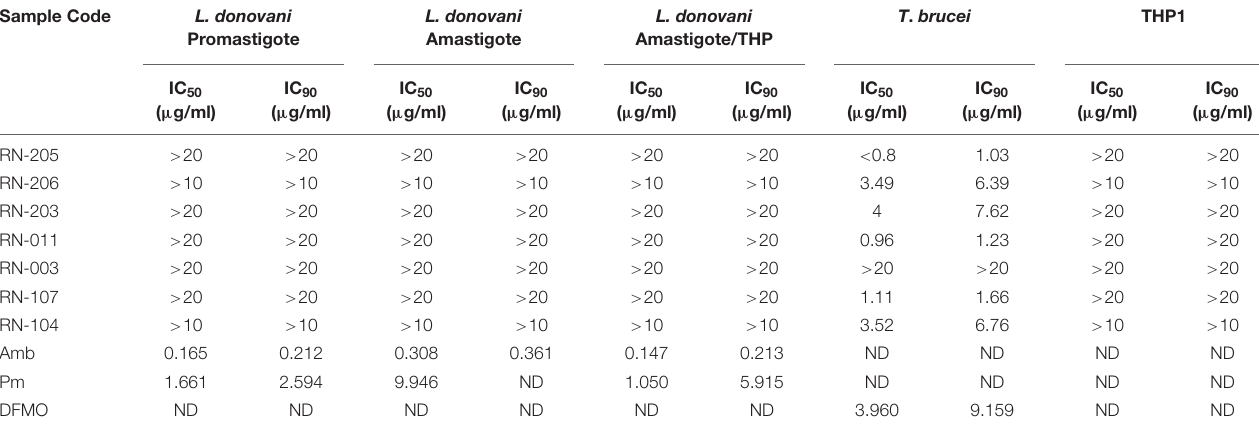
TABLE 4 | Antileishmanial and antitrypanosomal assays of the EtOAc extracts of the isolated microorganisms showing high antitrypanosomal activity by metabolites of Streptomyces indiaensis RN-205 and Bacillus sp. RN-011. Sample